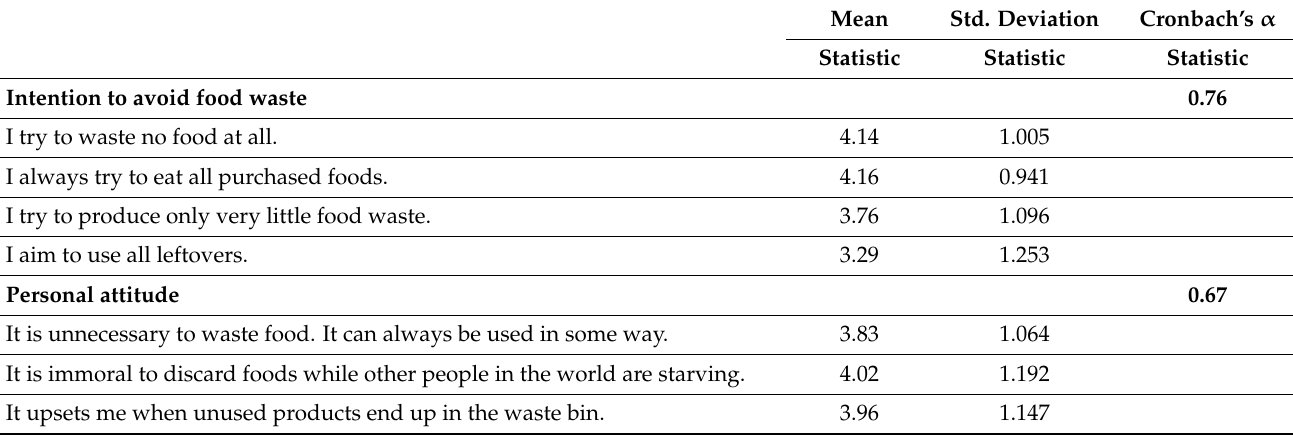
Table A1. Questionnaire items per construct, including the mean, standard deviation and internal reliability (Cronbach’s α